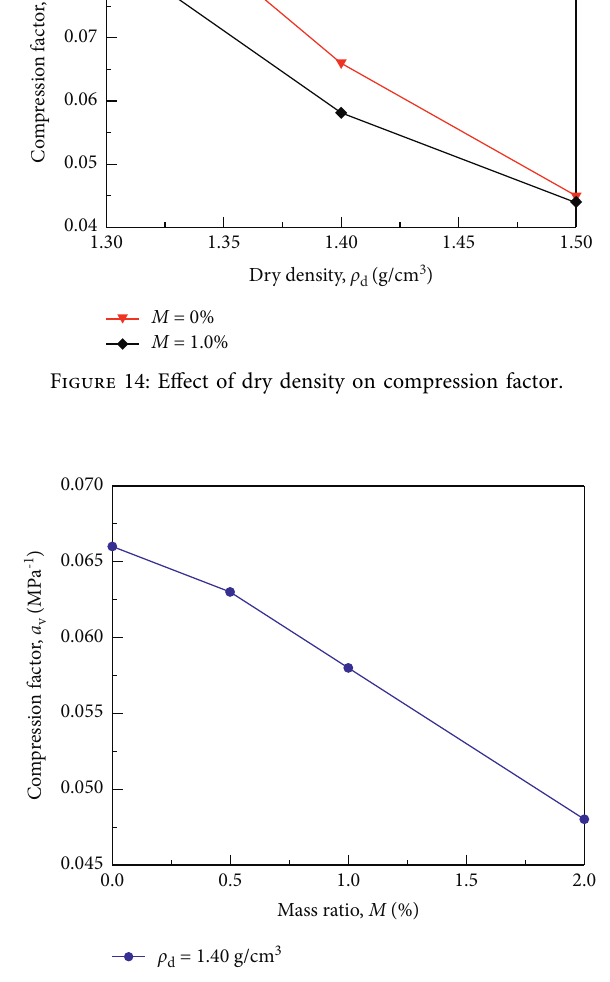
Figure 15: Effect of mass ratio on compression factor.